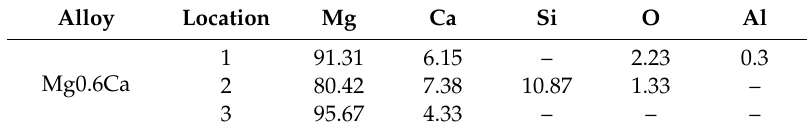
Table 4. EDS analysis (at.%) of Mg0.6Ca alloys at the locations of SKPFM mapping as per Figure